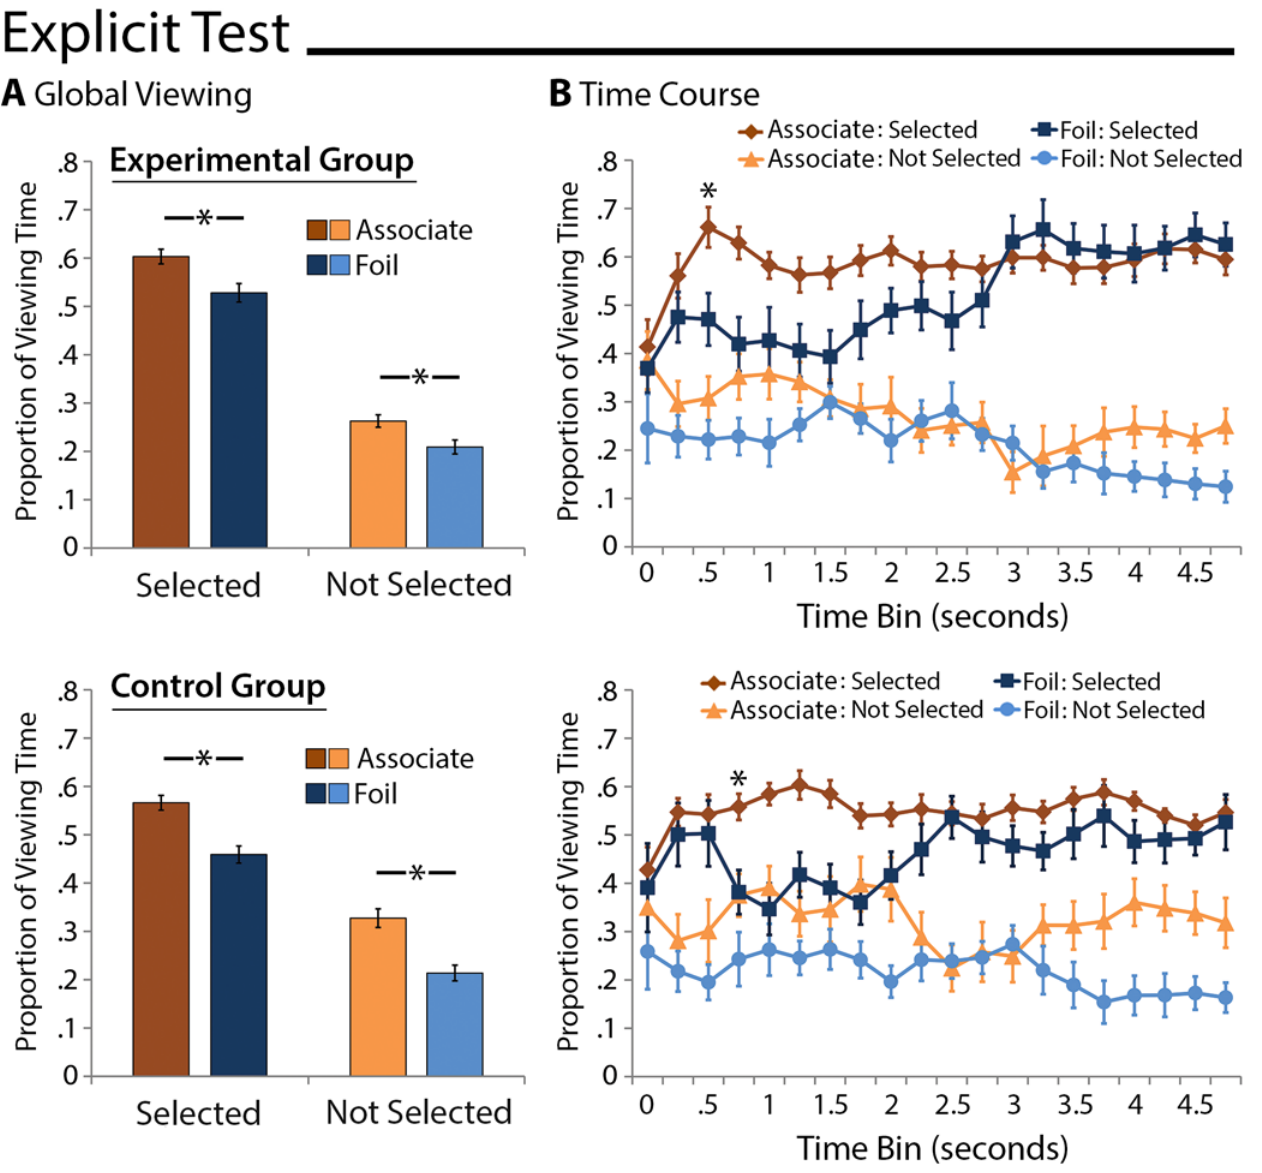
Fig 5. Explicit Memory-Based Viewing Effects. A) Proportion of total viewing time directed to faces of interest collapsed across the duration of the entire test trial for the experimental group (top) and the control group (bottom). More time was spent viewing selected faces, and participants looked disproportionately at the associates of scene cues whether explicit recognition responses were correct or not. B) Proportion of total viewing time directed to faces of interest broken down into 250ms time bins starting with 3-face display onset. Selected faces were prioritized, and memory-based viewing that distinguished correctly identified associates from faces selected in error were evident for both groups shortly after display onset. Error bars indicate standard errors of the